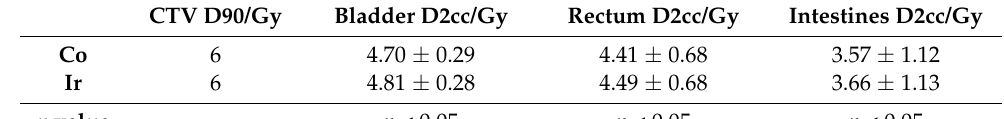
(cid:0) (cid:1) X + S .